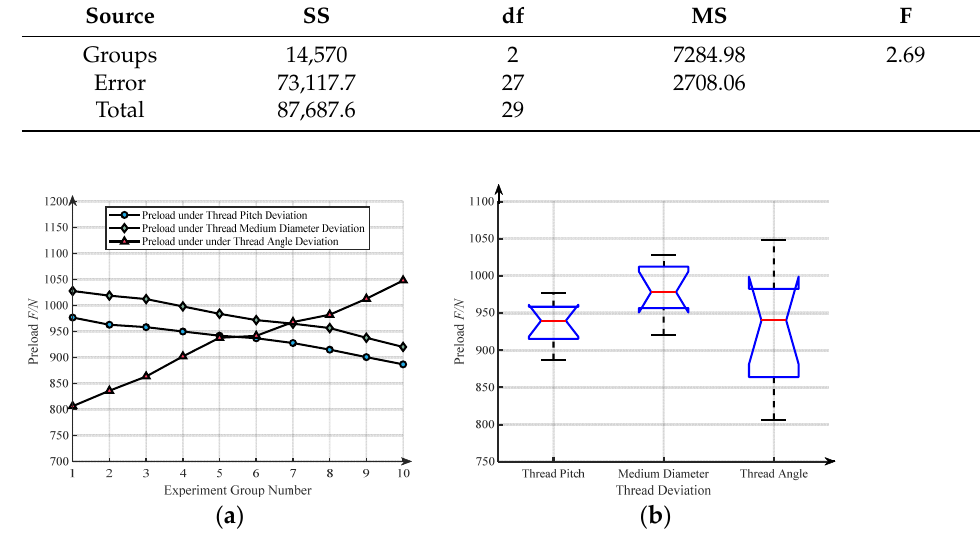
Figure 11. ( a ) Experimental tightening curve, ( b ) One-way ANOVA results. Based on the experimental test data of each group, the same amount of geometric deviation was set in the finite element model with the friction coefficient of each contact surface obtained from the test to calculate the preload force values under the same condi- tions. A comparison of the final preload forces between the simulation and the test is shown in Figure 12a–c. The final preload forces calculated from the simulation of the finite element model are in general agreement with the test data, with a maximum error of 2.4%. The simulated model and the test basically match for the same geometrical deviation, indicating that the results of the finite element model analysis are reliable.